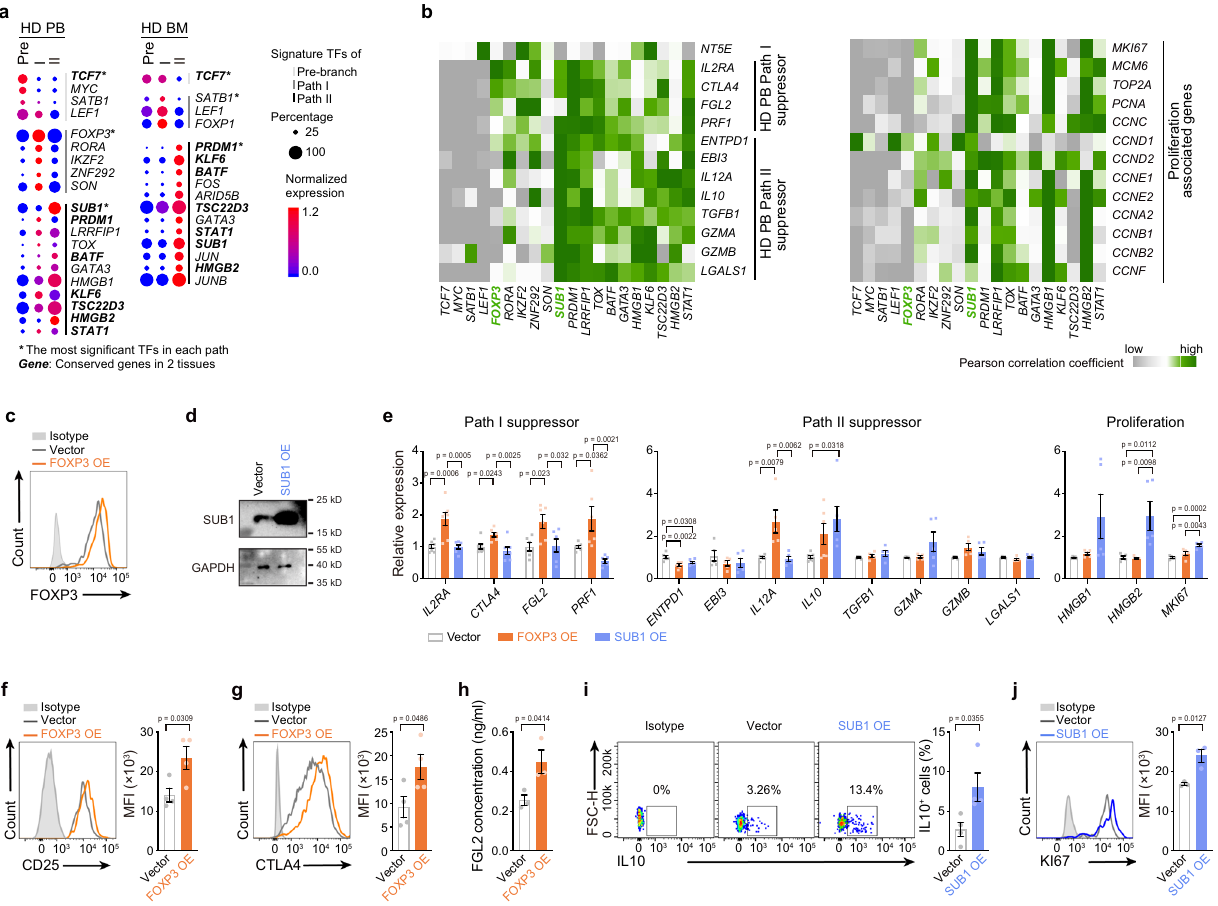
Fig. 5 Transcription factors enriched in T reg cell differentiation paths. a Dot plots showing the transcriptional factors (TFs) which were differently expressed in each T reg cell path (p < 0.05, log FC > 0.28), ordered by p value. The dot size represents the percentage of cells that express the indicated genes, and the dot color shows the averaged level of expression. FC: fold change. b Correlograms visualizing the correlation of single-cell gene expression pro fi les between TFs and suppression or proliferation genes in HD PB samples. c FOXP3 protein levels in HD PB T reg cells, 5 days after transfection with FOXP3 overexpression virus, as measured by fl ow cytometry. Experiment repeated at least three times. d SUB1 protein levels in HD PB T reg cells, 5 days after transfection with SUB1 overexpression virus, as measured by western blot. Experiment repeated three times. e Expression of the mRNA level of indicated genes in HD PB T reg cells, 5 days after transfection with FOXP3 or SUB1 overexpression virus, as measured by RT-qPCR ( n = 5 – 7). Experiment repeated at least three times. f – j Expression of CD25, CTLA4, FGL2, IL10 and KI67 in HD PB T reg cells, 5-6 days after transfection with FOXP3 or SUB1 overexpression virus, as measured by fl ow cytometry ( f , g , i , j ) or ELISA ( h ) (CD25: n = 4, CTLA4: n = 4, FGL2: n = 3, IL10: n = 4, KI67: n = 3). Experiment repeated three times. In e , p values were determined by One-way ANOVA; In f – j , p values were determined by two-sided unpaired t -test; data are presen t ed as mean values ± SEM. Source data are provided as a Source Data fi T reg paths in allo-HSCT patients with or without aGVHD . T reg cells from allo-HSCT patients preserved the two differentiation paths, mostly with the FOXP3 hi subset at the Path I terminus (except non-aGVHD BM), and with the MKI67 hi subset at the Path II terminus (Fig. 7a, Supplementary Fig. 10a, Supplementary Data 8). Allo-HSCT patients also expressed high levels of sup- pressor genes LGALS1 and cell cycle genes TOP2A , PCNA , and MCM6 in Path II, and expressed high levels of suppressor genes IL2RA , CLTA4 , and FGL2 in Path I, similar to healthy donor T reg cells (Supplementary Fig. 10b). GSVA demonstrated that in allo- HSCT patients, Path II still had higher TCR signaling, suppres- sion, migration, cell cycle, apoptosis, glycolysis, and TCA than Path I, similar to the observations in healthy donors (Fig. 7b). These results suggested that the two-path differentiation modes